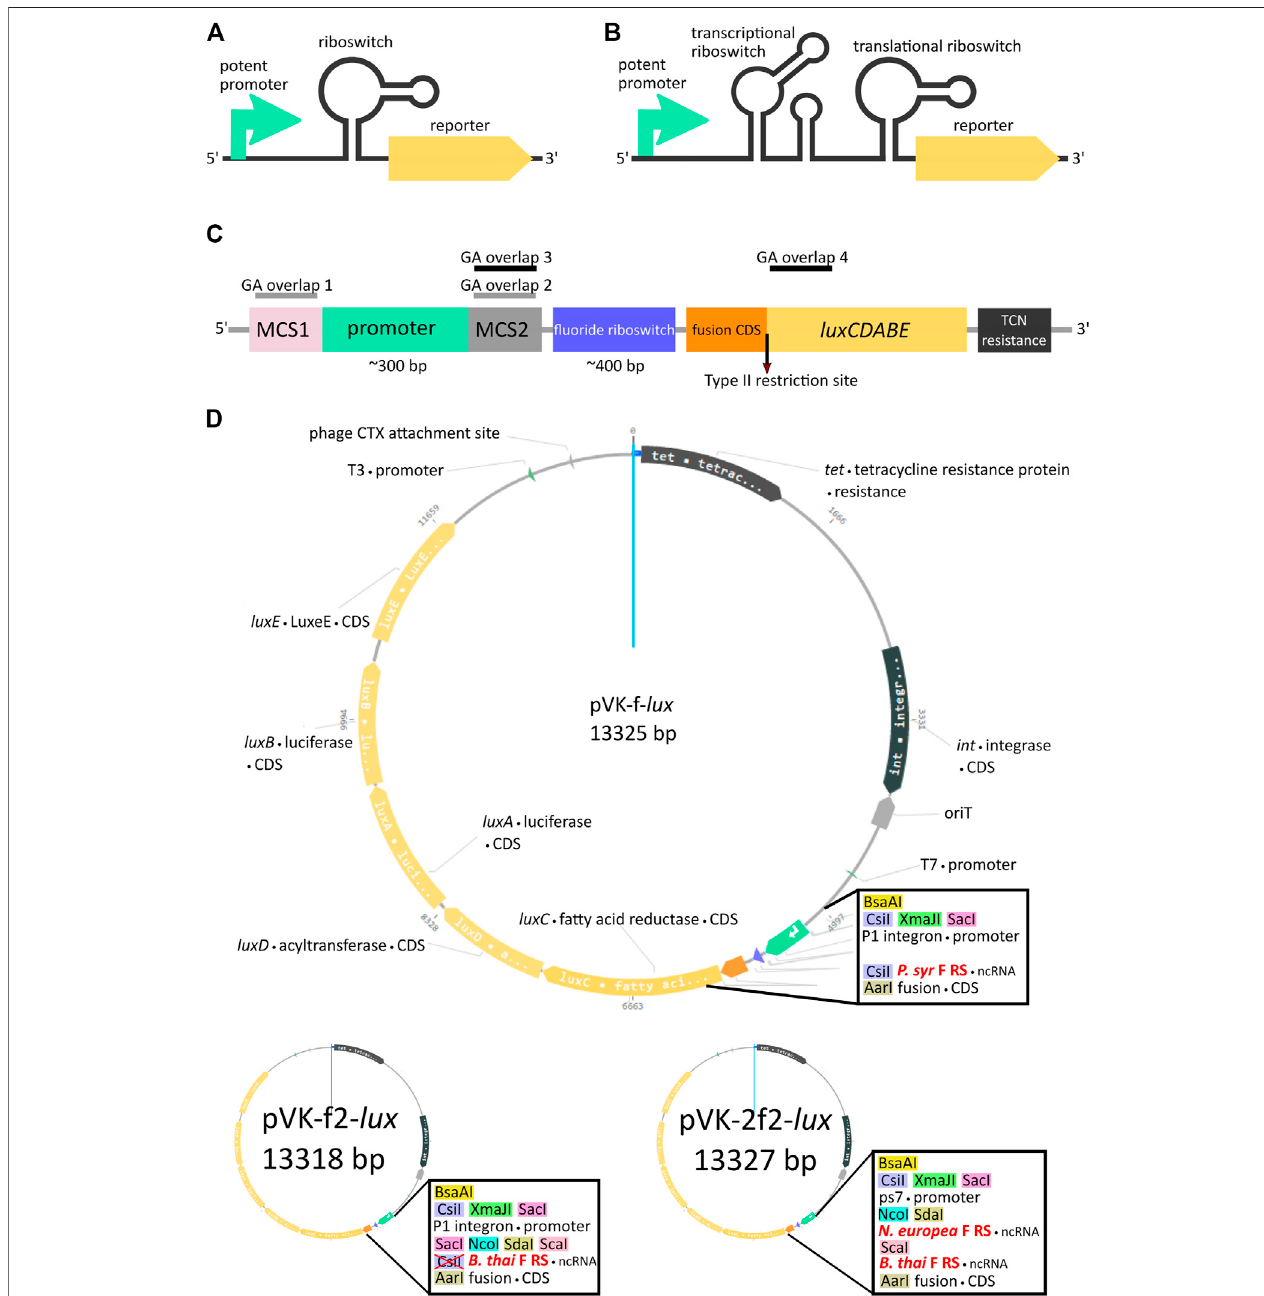
FIGURE 1 | Riboswitch-mediated reporter expression under the control of a potent promoter. Schematic diagram of a potent promoter dampening strategy with one (A) or two (B) riboswitches. (C) Key features of pVK-f- lux , a parts-swappable mini-CTX- lux derived backbone for convenient cloning of promoters and RNA regulatory parts. MCS1 contains CsiI-XmaJI-SacI restriction sites and MCS2 contains NcoI-SdaI-ScaI restriction sites. A type IIS restriction site is located at the beginningof luxC allowing digestion intothe second codon for scar-free translational fusion. GAoverlaps for double digestionswith SacI and NcoI or ScaI and AarI have been designed for allowing interchangeability of parts as described ( Supplementary Material : Quick User Manual for pVK-f- lux ). These double digestions are buffer compatible and yield fragments visible on an agarose gel (approximately 300 and 400 bp in length, see Supplementary Figure S3 for more details). (D) Plasmid map of pVK-f- lux and pVK-f2-